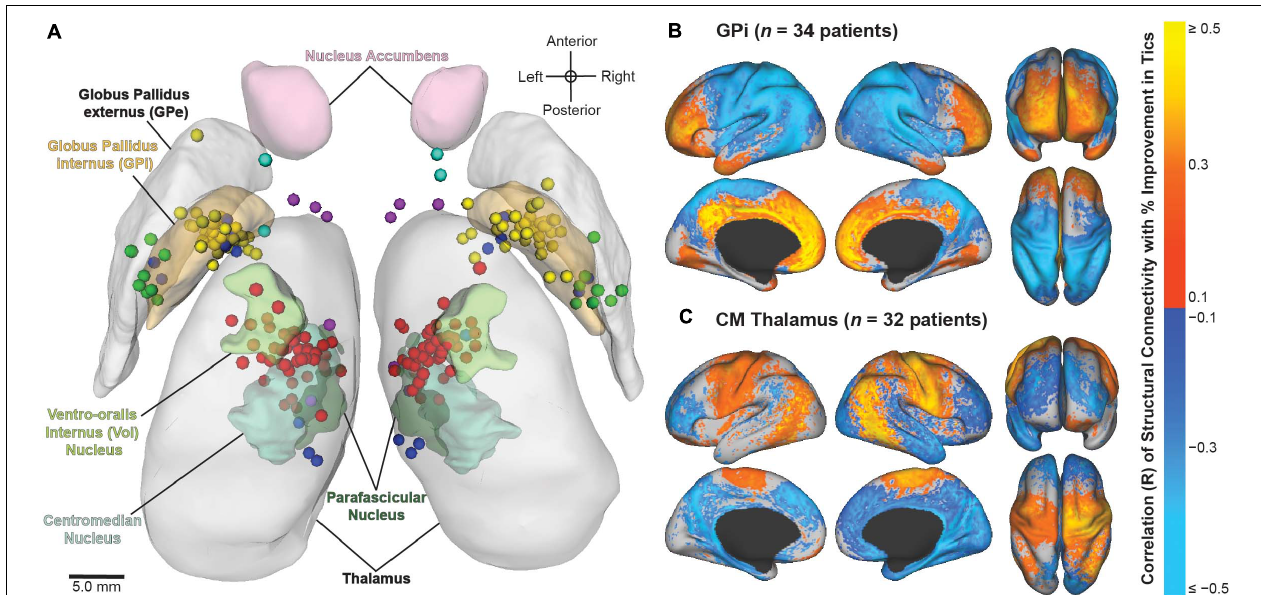
FIGURE 5 | Image-based analyses of multicenter data from the International Tourette Syndrome (TS) Deep Brain Stimulation (DBS) Registry and Database. (A) Active contact locations for N = 70 patients implanted in the centromedial (CM) thalamus (red); anteromedial globus pallidus internus (GPi) (yellow); posteroventral GPi (green); nucleus accumbens/anterior limb of internal capsule (NA/ALIC) (turquoise); CM thalamus and GPi (blue); or CM thalamus and NA/ALIC (purple). From Johnson et al. (2019). (B,C) Stimulation-dependent structural connectivity associated with improvement in tics in patients implanted with DBS in the (B) GPi or (C) CM thalamus. From Johnson et al.